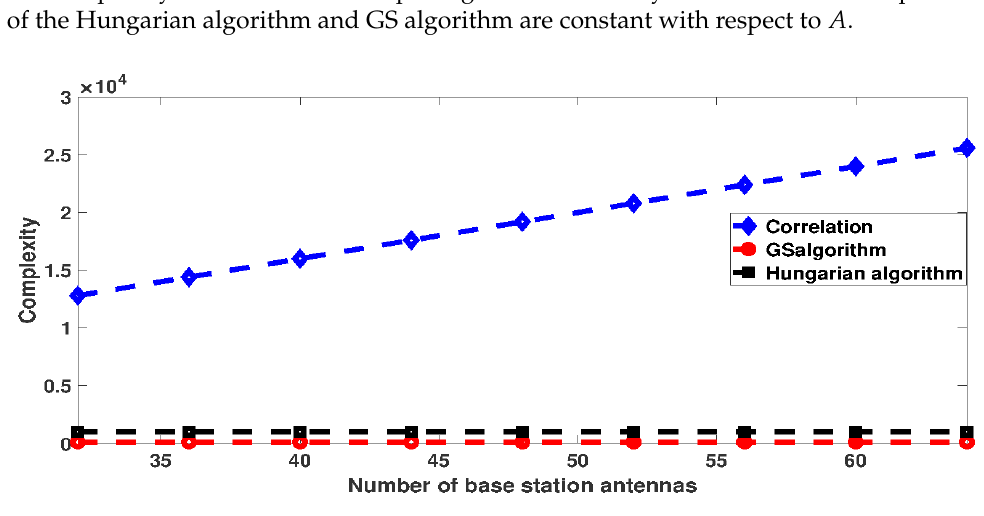
Figure 7. Complexity versus number of BS antennas, with U = 20 users.